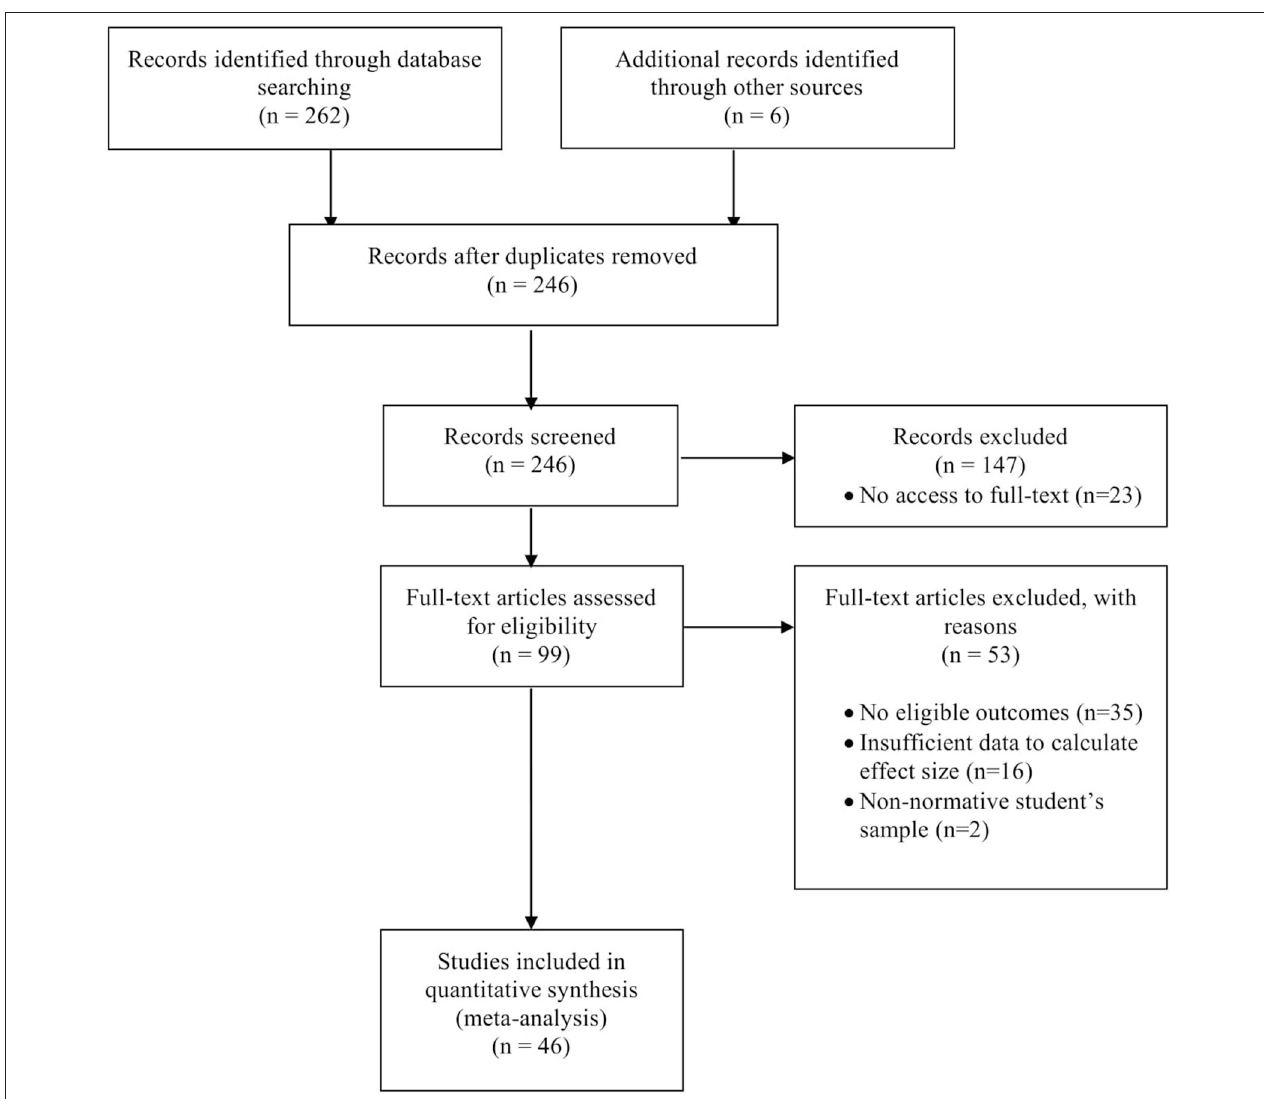
FIGURE 1 | Flow diagram for studies included in the